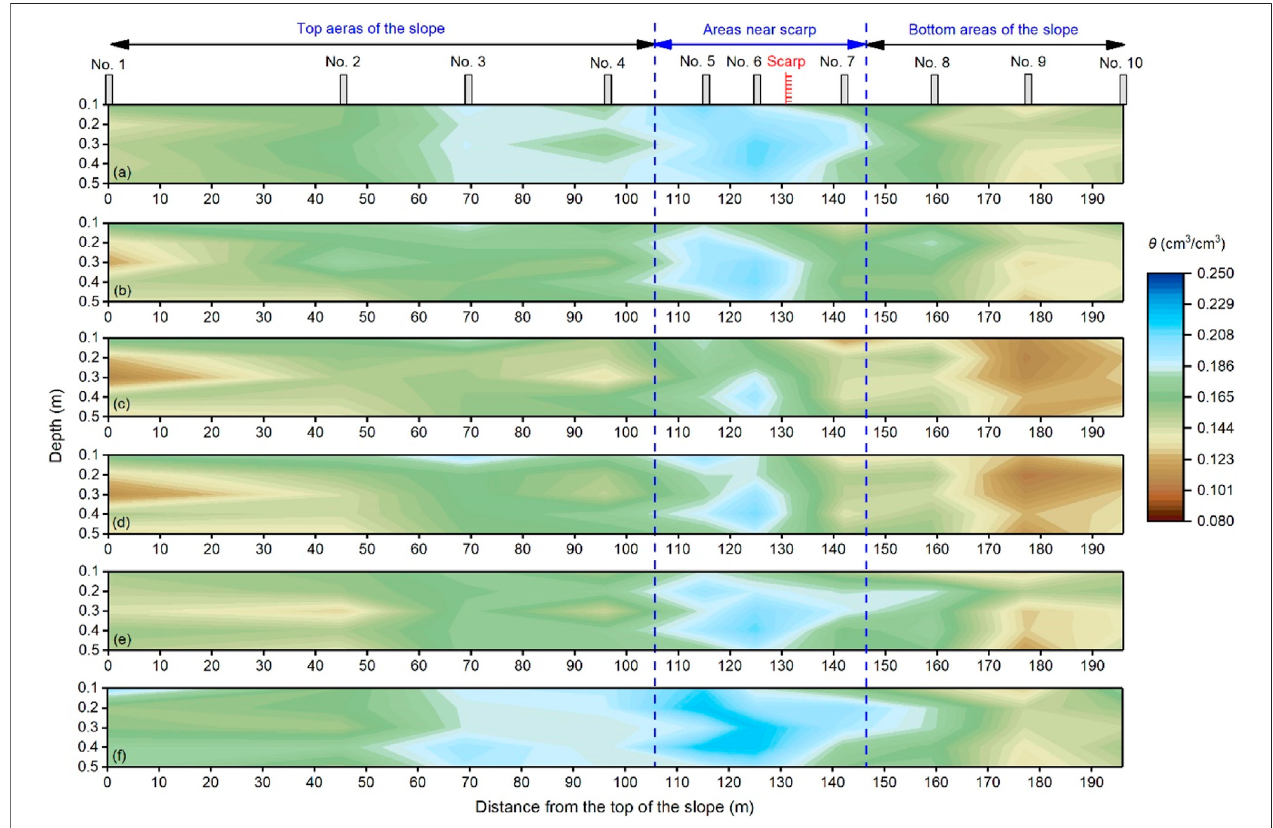
FIGURE 7 | Soil water content distribution of the slope in different months. (A) 2019/11/10. (B) 2019/12/10. (C) 2020/1/10. (D) 2020/2/10. (E) 2020/3/10. (F) 2020/4/10 (Sun et al., 2021).